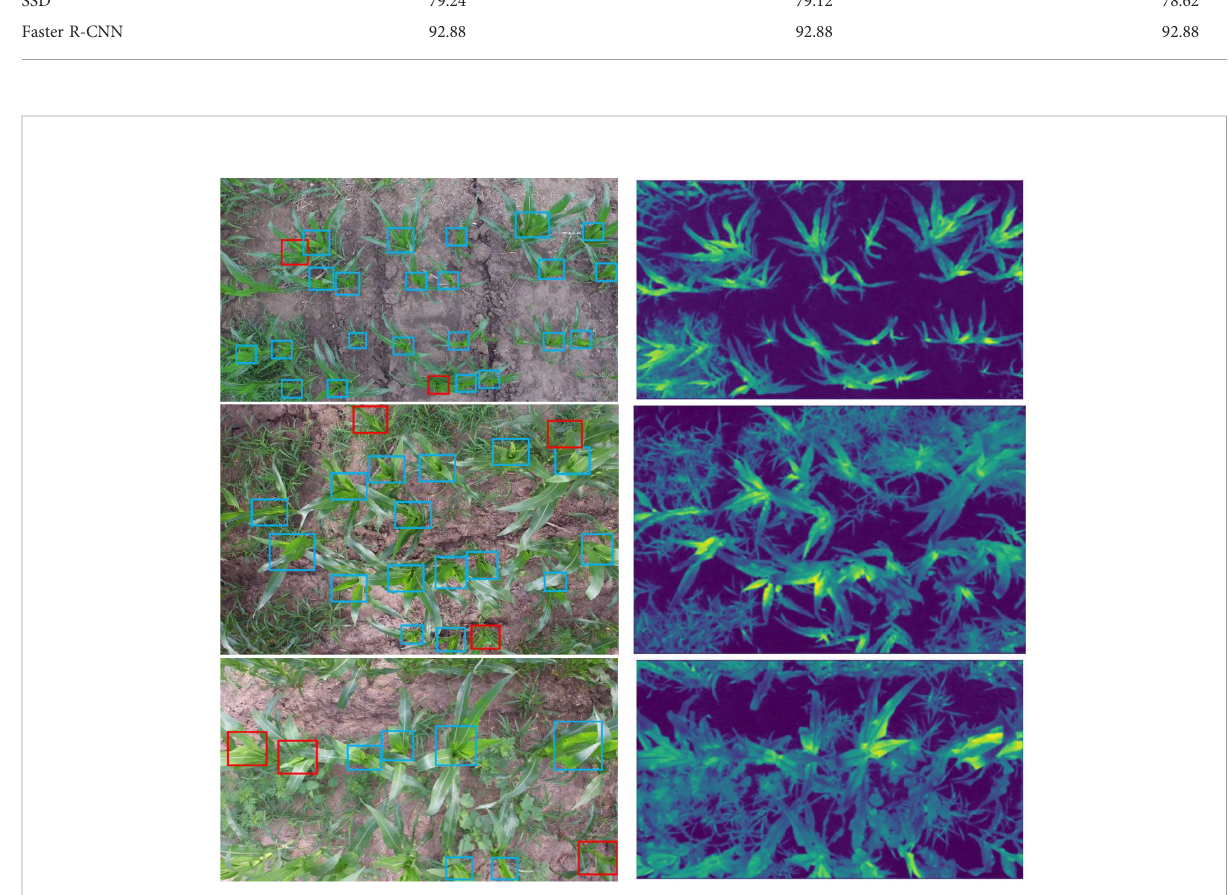
FIGURE 6 Detection results and feature maps of SE-YOLOV5m under different weed proportions. The left column shows detection results; the right column shows the corresponding feature maps of the last layer in the fi rst C3_2 module of SE-YOLOV5m. From top to bottom are representative images with weed proportions less than 30%, between 30% and 60% and more than 60%, respectively. In the fi gure, the blue boxes and red boxes are the TP and FN